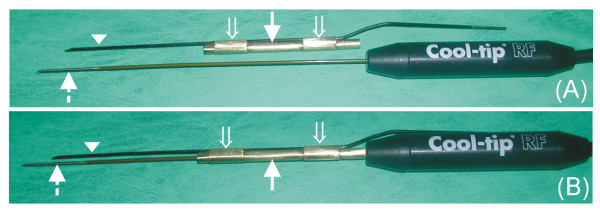
Applicator used in the experiments to test the effect of perfusion distance. An insulated perfusion needle (arrowheads) attached to a metallic outer sheath (solid arrows) by means of two fixation systems (open arrows) and a 17-gauge internally cooled electrode with a 3 cm exposed tip (broken arrows) (A). Once the metallic outer sheath is fitted to the internally cooled electrode, the perfusion needle remains parallel and midway from the exposed tip of the internally cooled electrode (B). The bottom photo shows the case of a perfusion distance of 2 mm.